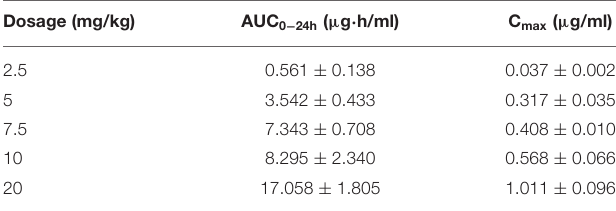
TABLE 3 | Study on the PK/PD of tulathromycin against Actinobacillus pleuropneumoniae in the tissue cage infection